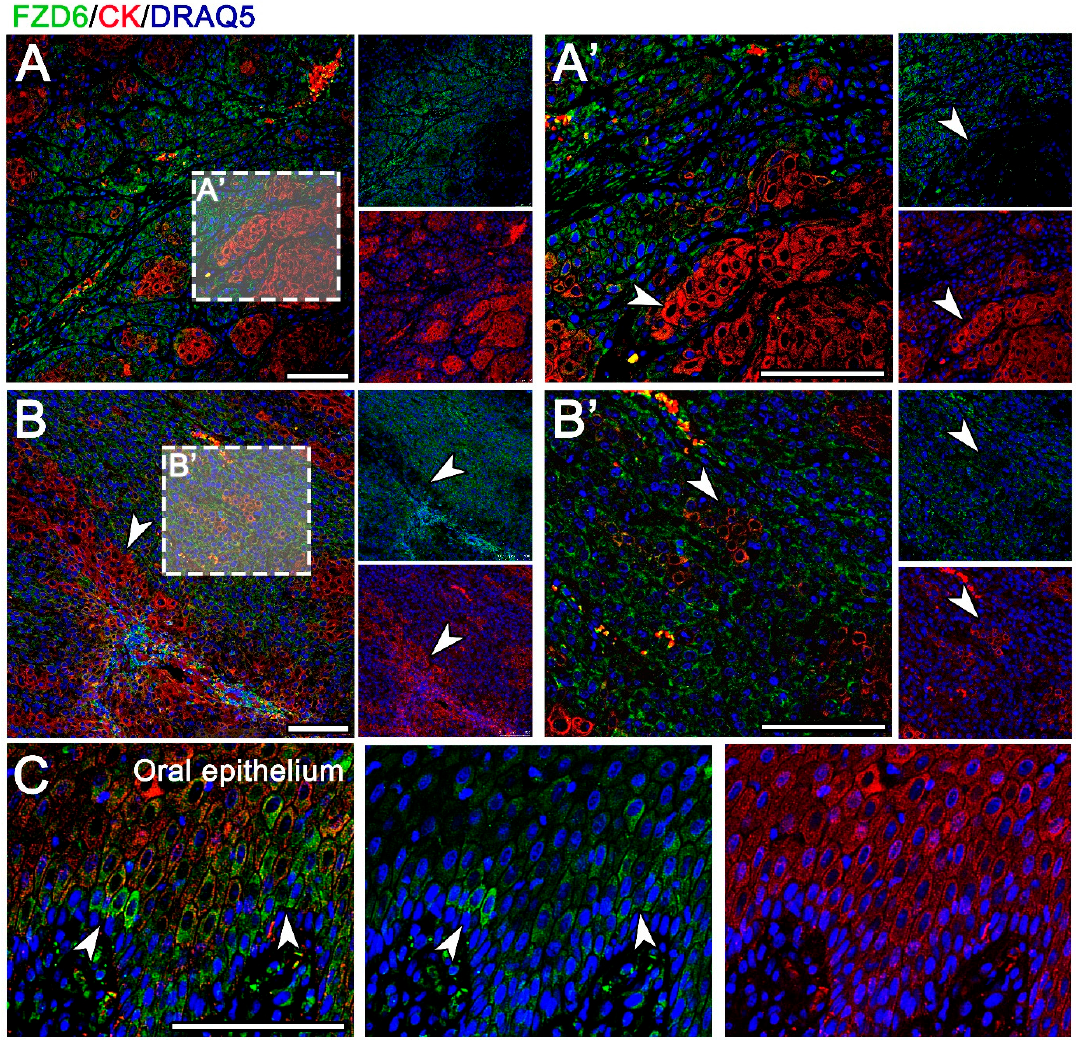
Figure 4. Expression of FZD6 in COSCC. ( A ) In a well-differentiated OSCC, FZD6 is expressed in the neoplastic epithelium and in the tumorous stroma. ( B ) In poorly differentiated OSCC with low expression of cytokeratin, the FZD6 signal is diffusely dispersed. ( A ’, B ’) There is a distinct negative correlation between cytokeratin signal and FZD6 expression in OSCC (arrowheads). ( A ’) The invasive front with areas of tumor budding demonstrates high FZD6 expression with a loss of cytokeratin expression. ( C ) Normal canine oral epithelium displays scattered cytoplasmic positivity mostly in the basal layer (arrowheads). Scale bar = 100 µm.